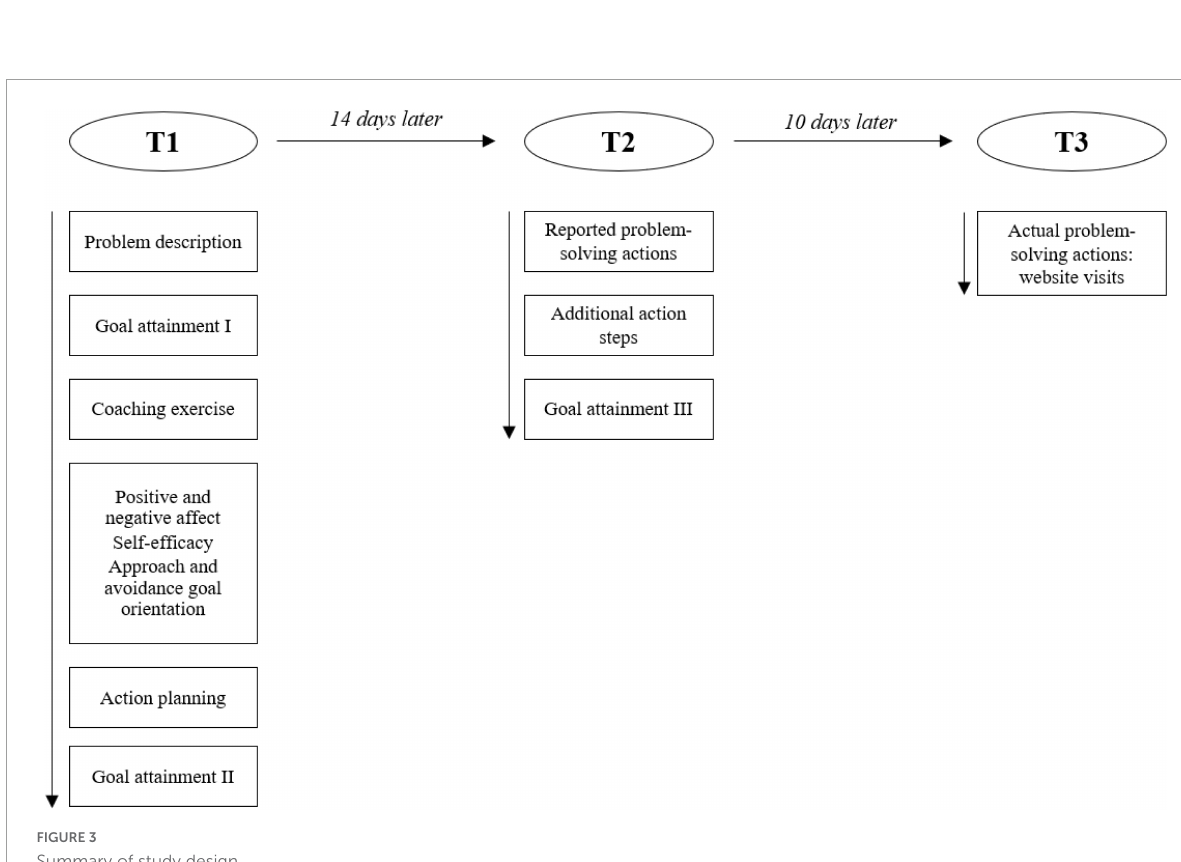
FIGURE3 Summary of study